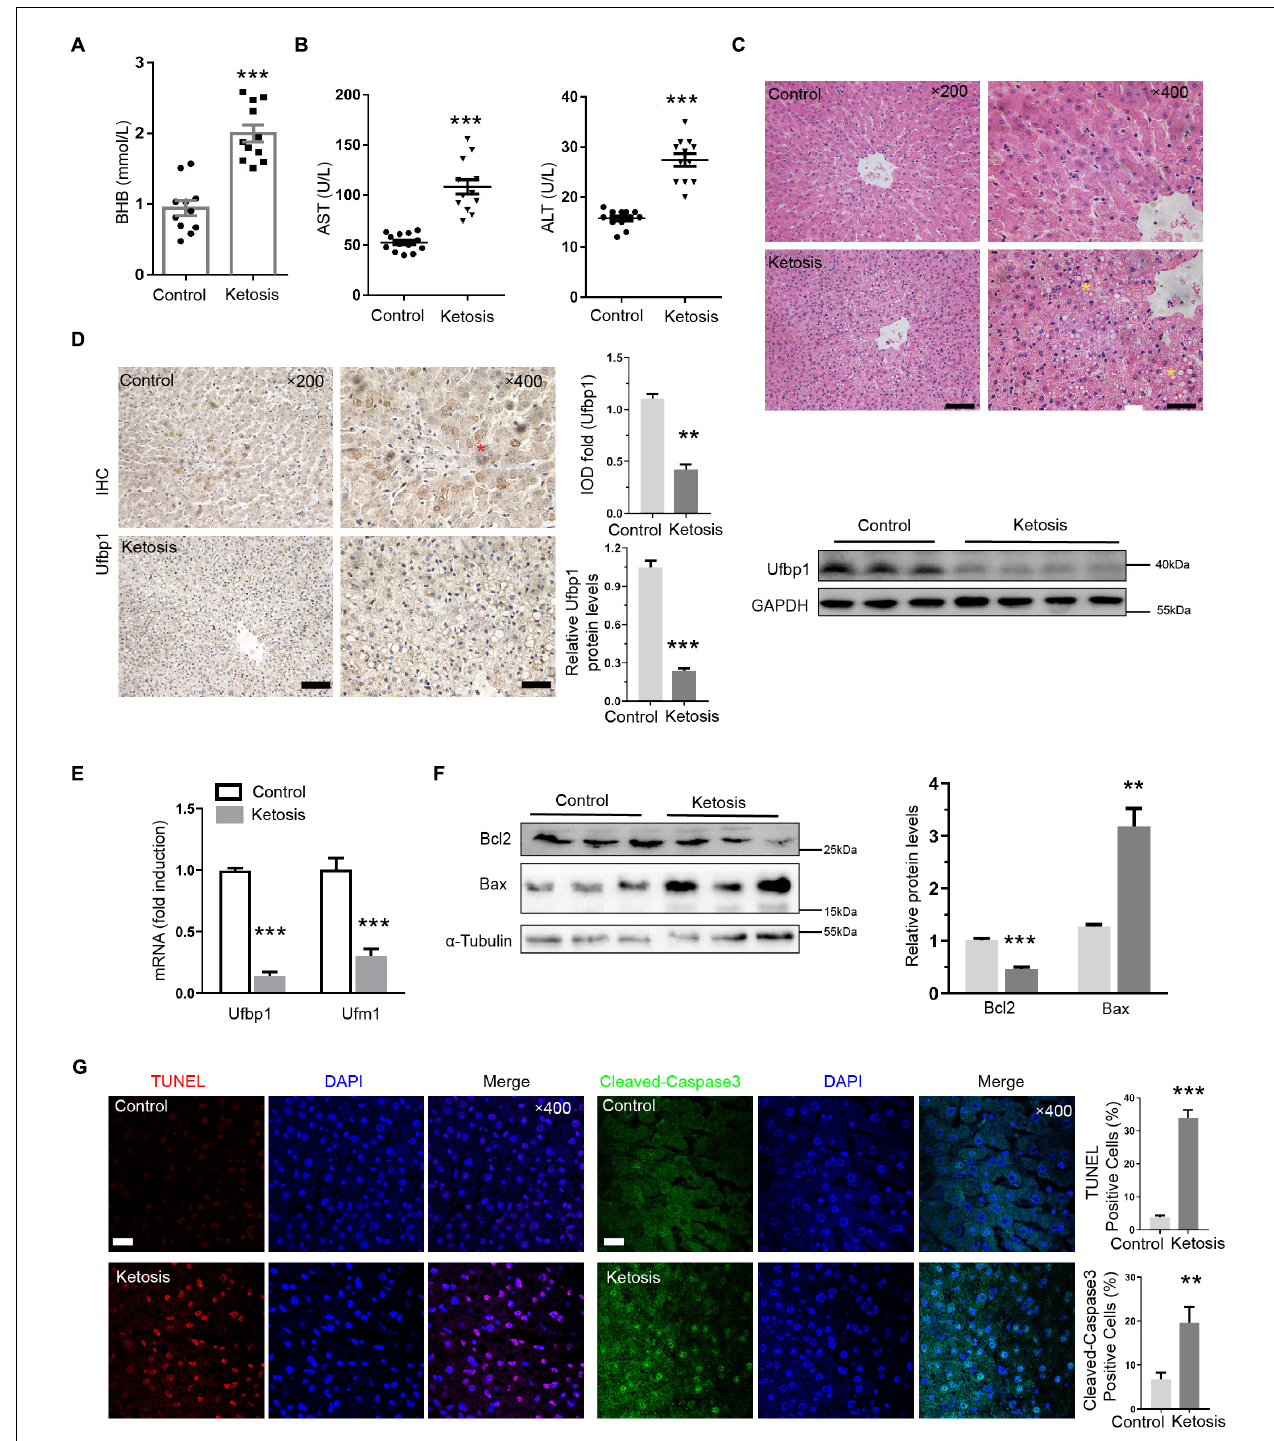
FIGURE 1 | Reduced Ufbp1 expression in liver damage caused by ketosis. (A) Blood concentrations of BHB ( n = 10–15). (B) Serum levels of alanine aminotransferase (ALT) and aspartate transaminase (AST) ( n = 10–15). (C) Representative pictures of hematoxylin and eosin staining (area of hepatic steatosis, identified by stars). (D) Immunohistochemistry and Western blotting revealed expression of Ufbp1 in liver tissues ( n = 3–4). (E) mRNA expression of Ufbp1 and Ufm1. (F) Protein expression levels of Bcl-2 and Bax were analyzed by Western blotting ( n = 3). (G) TUNEL staining and quantification of TUNEL-positive cells (red). Anti-cleaved caspase3 immunofluorescence in nucleus of apoptotic cells (green) and quantification. Data are reported as mean ± SEM. ** P < 0.01, *** P < 0.001, Scale bar = 50 µ m at × 200 or 20 µ m at × 400 magnification.